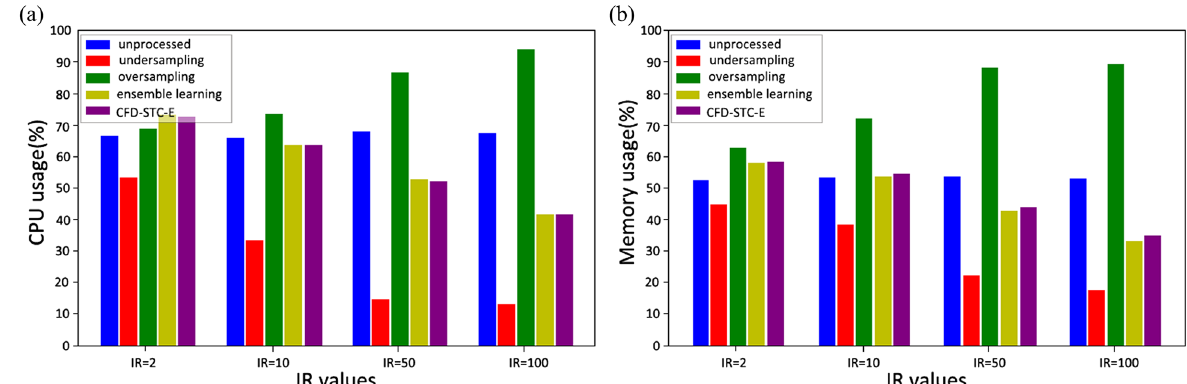
Fig. 13 Comparison of CPU and memory usage during training with different